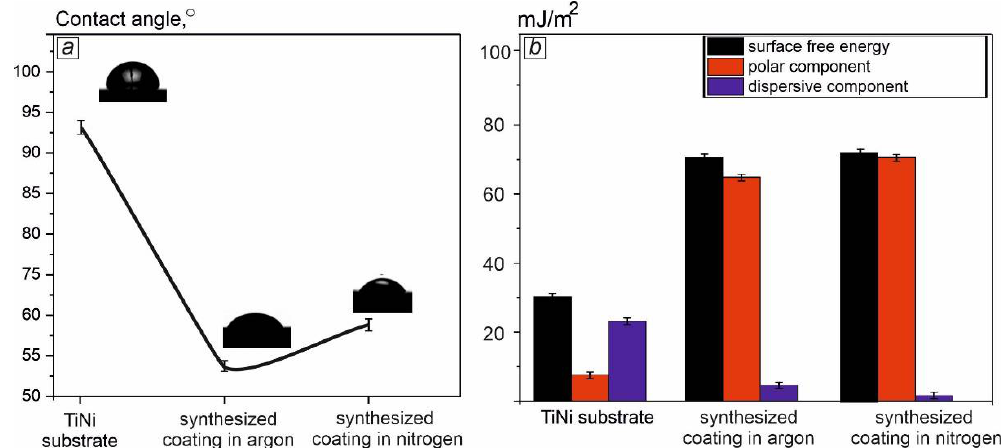
Figure 9. Contact angle ( a ) and surface free energy ( b ) values of the TiNi substrate, coating synthe- sized in argon atmosphere, coating synthesized in nitrogen atmosphere.